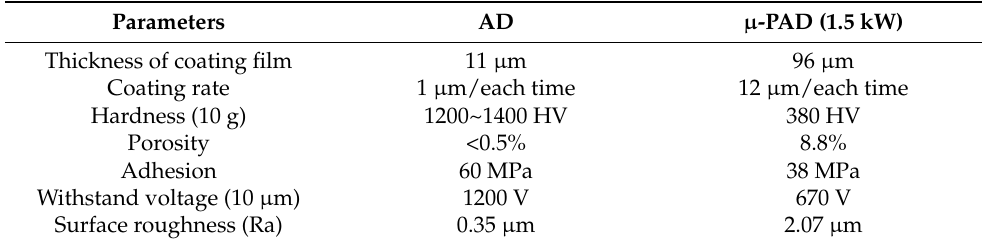
Table 2. Comparing characteristics of AD a nd μ -PAD coating films.